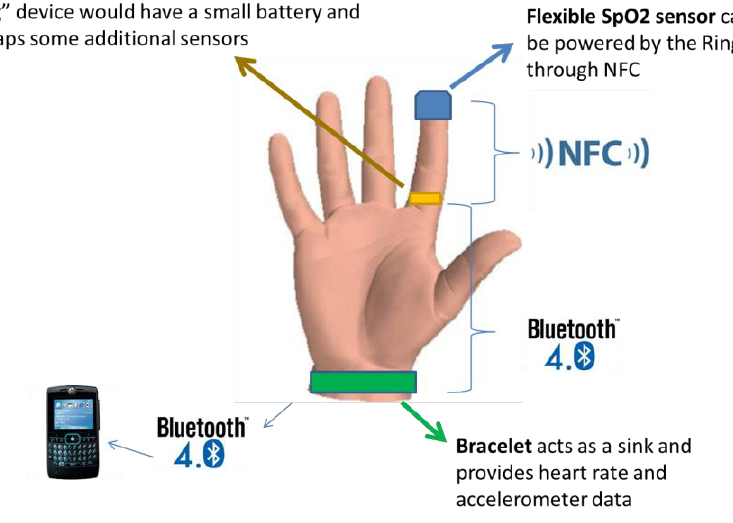
Figure 6. Possible combination of hand-worn sensors that can be used in a people-centric sensing